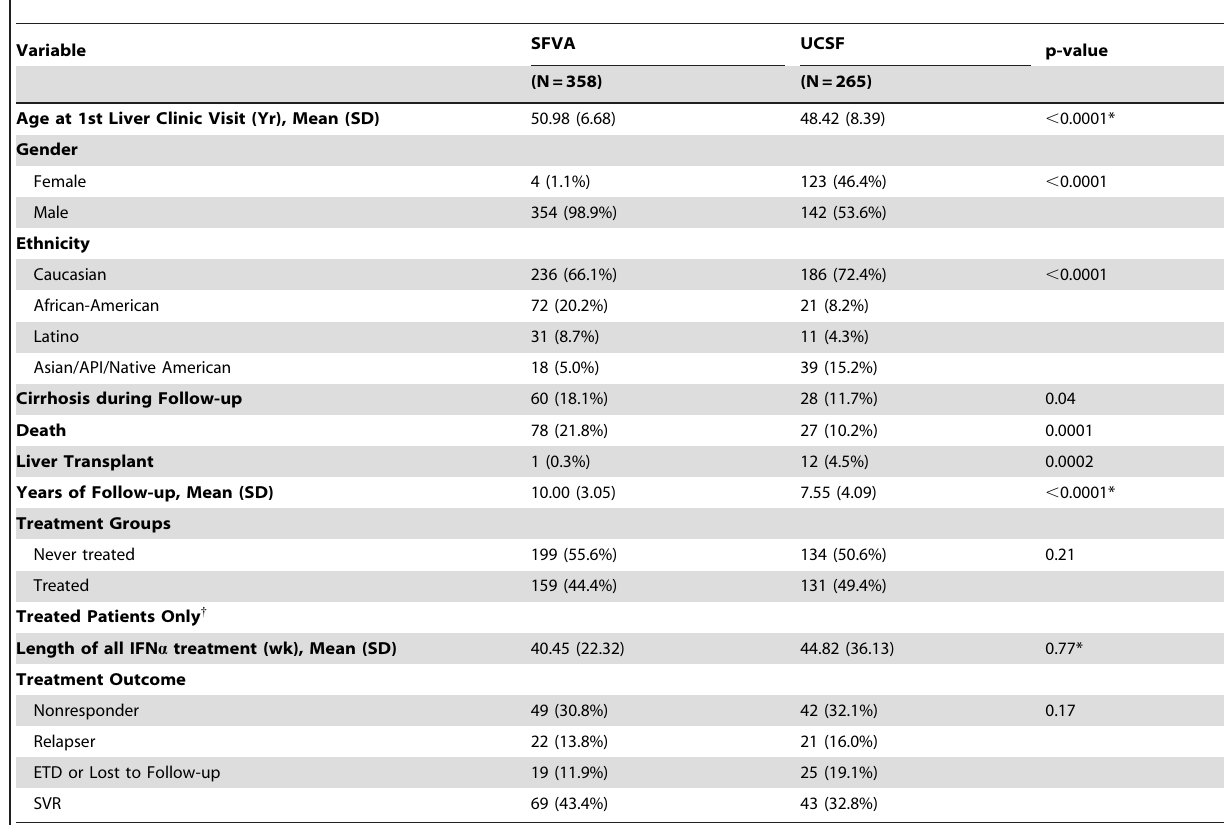
Table 4. Selected Characteristics of SFVA and UCSF HCV Cohorts.